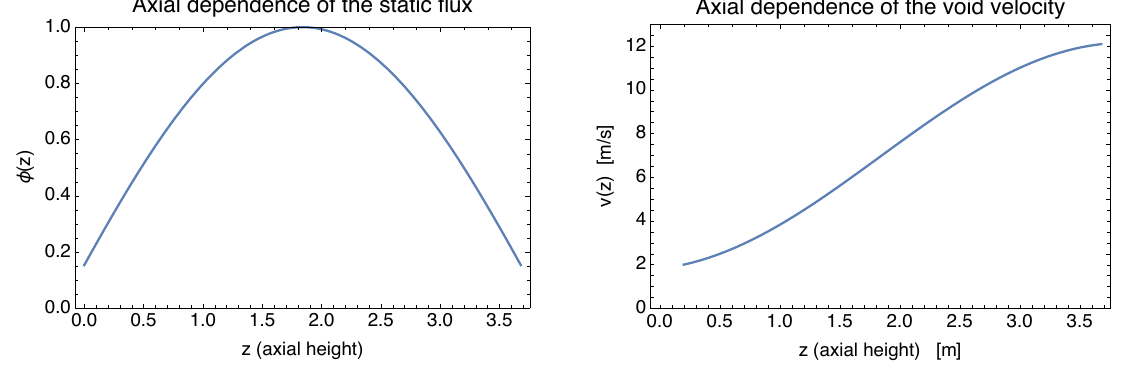
Figure 4: Flux and void velocity